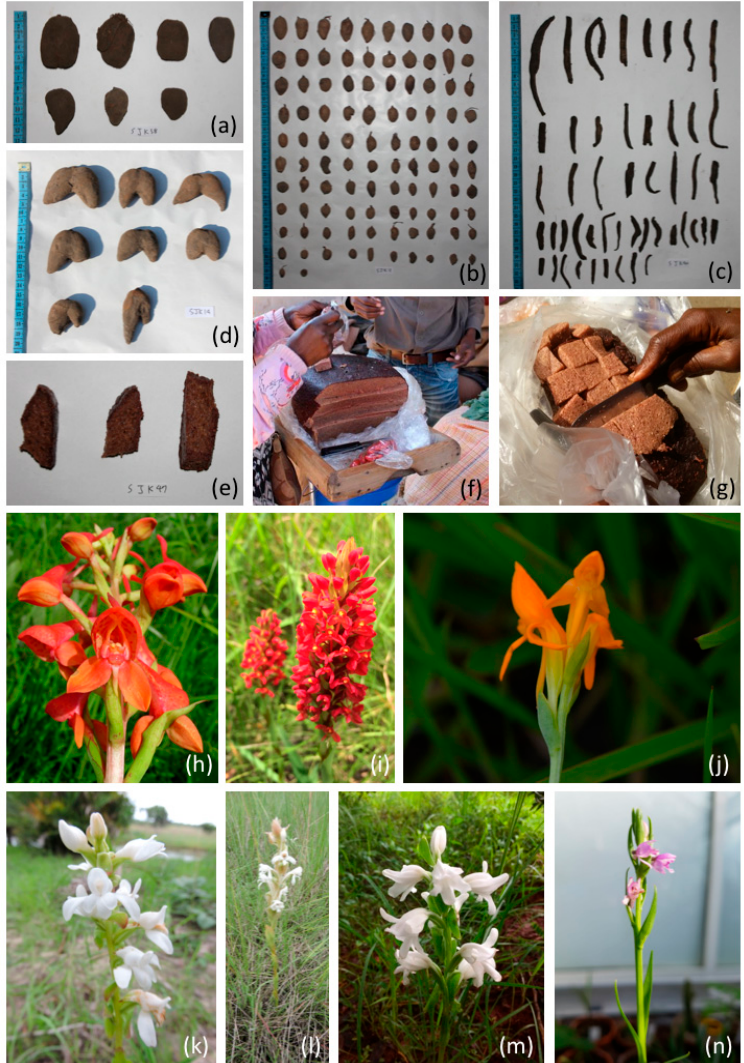
Figure 2. Chikanda tubers, cake and orchids. ( a ) Myala—real chikanda; ( b ) Mbwelenge—fake chikanda; ( c ) Mshilamshila—supposedly Brachycorythis sp.; ( d ) Mampanda. ( e – g ); Chikanda cake; ( h ) Disa robusta ; ( i ) Disa welwitschii ; ( j ) Platycoryne crocea ; ( k ) Satyrium carsonii ; ( l ) Satyrium buchananii ; ( m ) Satyrium kitimboense ; ( n ) Brachycorythis cf . friesii ; Photographs ( a – g ) by Seol-Jong Kim, ( h ) by Robert v. Blittersdorff, ( i , k , l ) by Nicholas Wightman, ( j ) by Warren McCleland, ( m ) by Ruth E. Bone and ( n ) by Sarina